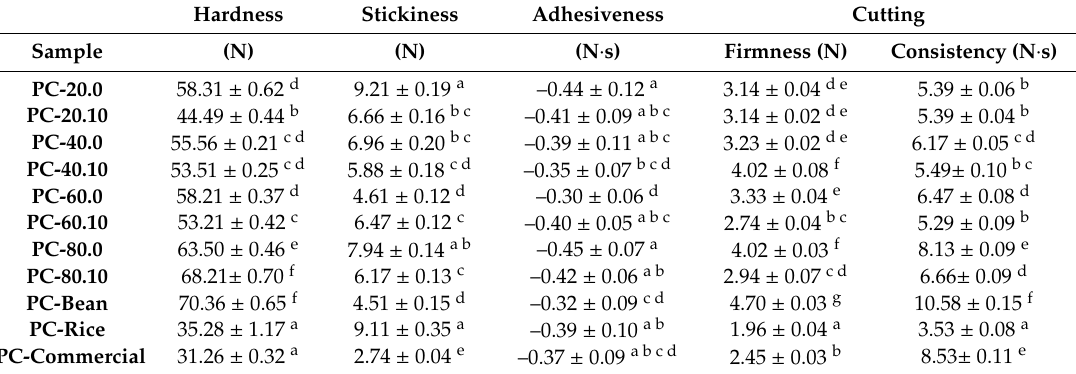
Table 7. Instrumental measure of the texture of the cooked fettuccine (PC-) and the commercial pasta